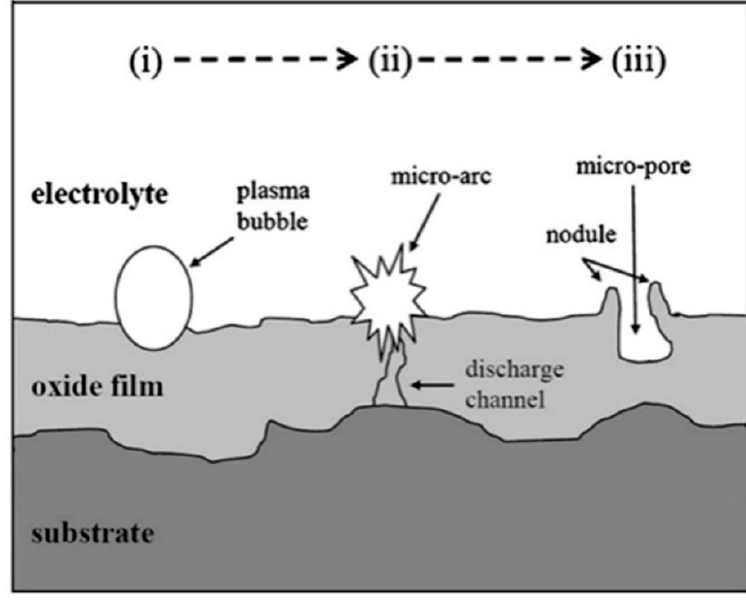
Figure 3. Schematic diagram of the PEO coating to form the oxide film by plasmabubble implosion: (i) Plasma bubbles take place on surface; (ii) Micro-arcs, whichare generated through the narrow discharge channels, lead to the implosion; and(iii) This implosion makes micro-pores in the oxide film [61].